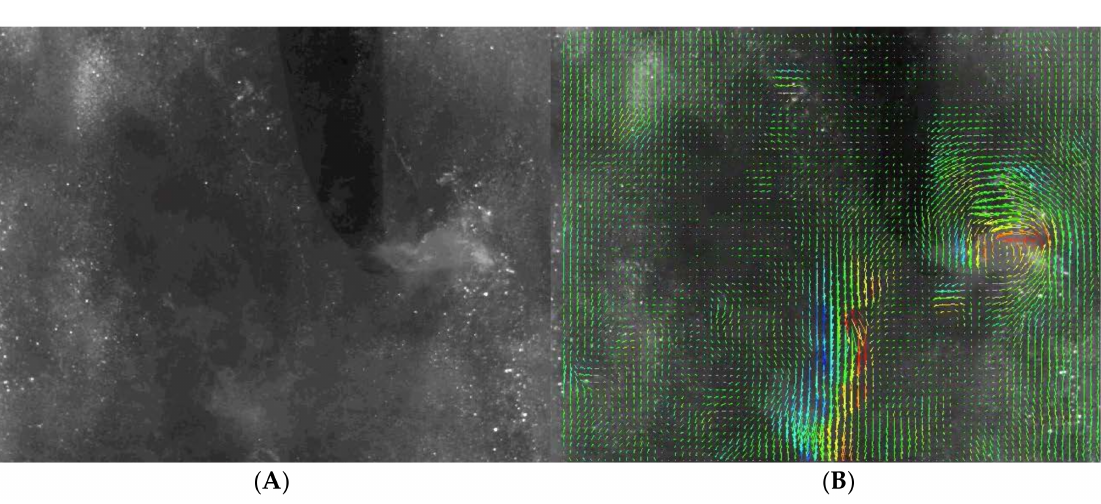
Figure 3. Displacement of bubbles ( A ) and vector flow from digital particle image velocimetry (DPIV) ( B ) as the flukes are moving to the left. The colored vectors show the vortex and jet